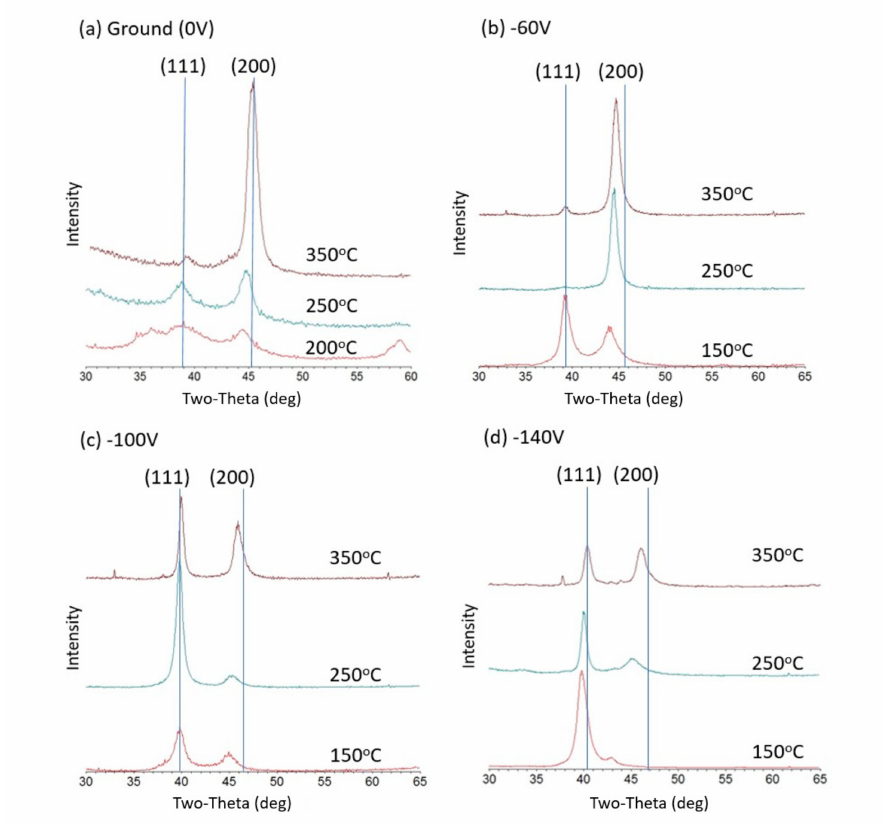
Figure 3. X-ray di ff raction results for deposited films collected using the Bragg-Bretano configuration and CuK α radiation. The spectra are shown for substrate bias levels of ( a ) 0 V, ( b ) − 60 V, ( c ) − 100 V and ( d ) − 140 V, each at three di ff erent temperatures as shown. The positions of the (111) and (200) lines are shown and their locations based on a method described in the